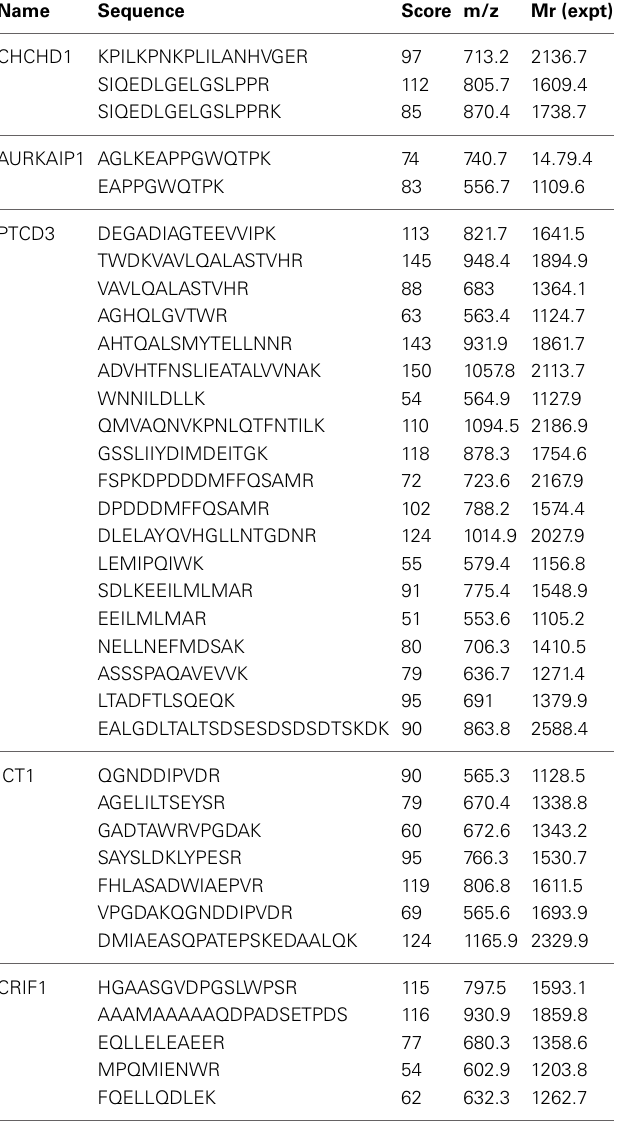
Table 1 | Peptide sequences of new mitochondrial ribosomal proteins identified from LC-MS/MS analyses of in-gel tryptic digestions of 28S, 39S, and 55S samples prepared at high salt